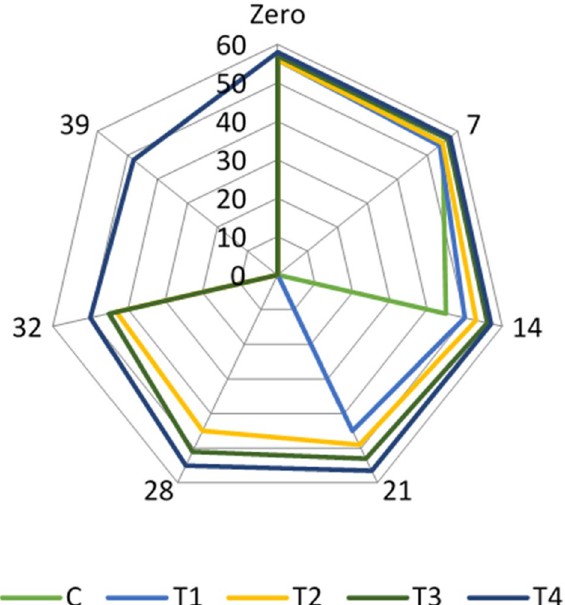
Figure 1. Flavour scores in the examined yogurt treatments throughout their refrigerated